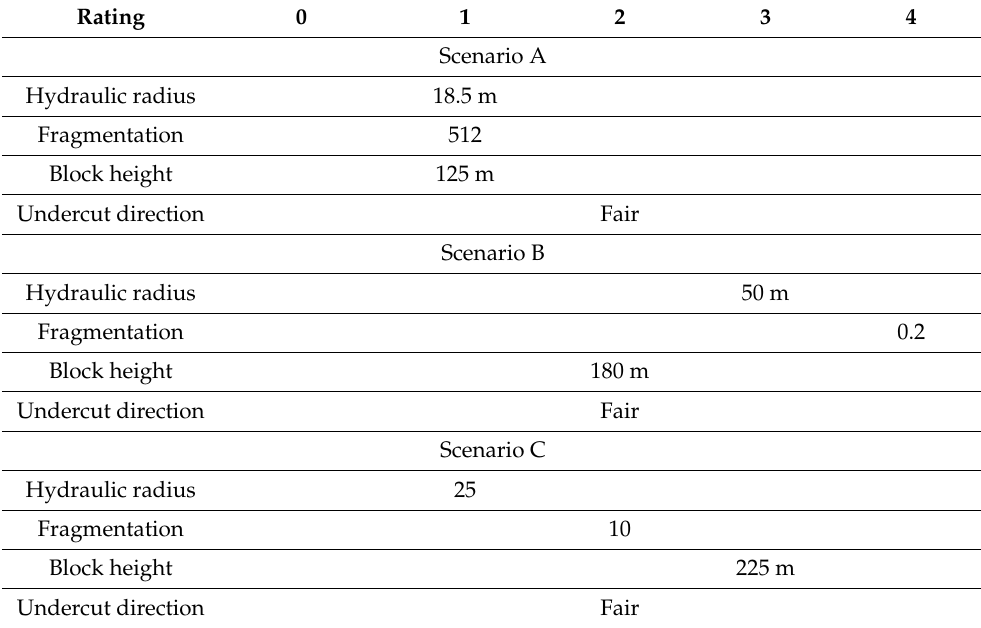
Table 3. Three scenarios are illustrated for long-term strategies for hydraulic fracturing